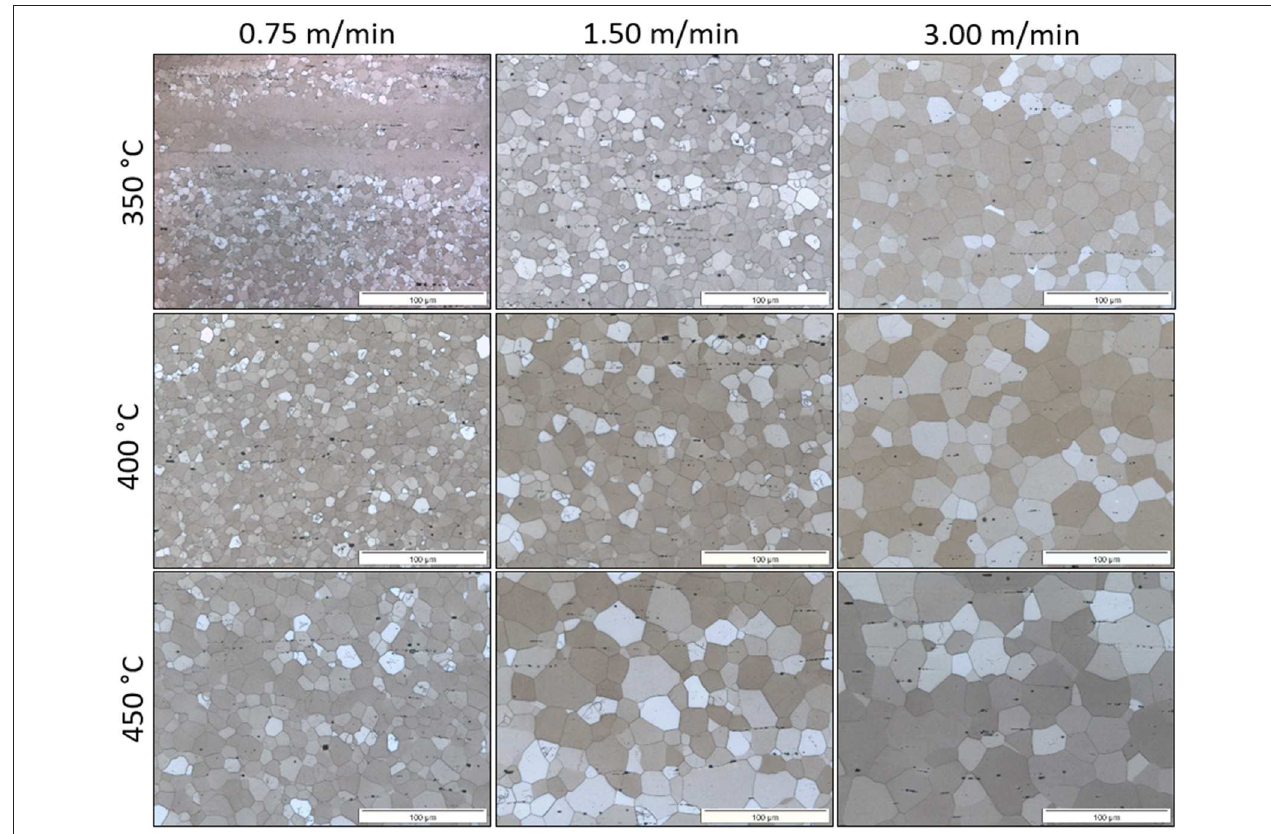
FIGURE 1 | Microstructure evolution of Mg-10Gd after indirect extrusion. Micrographs show longitudinal sections with extrusion direction to the right.